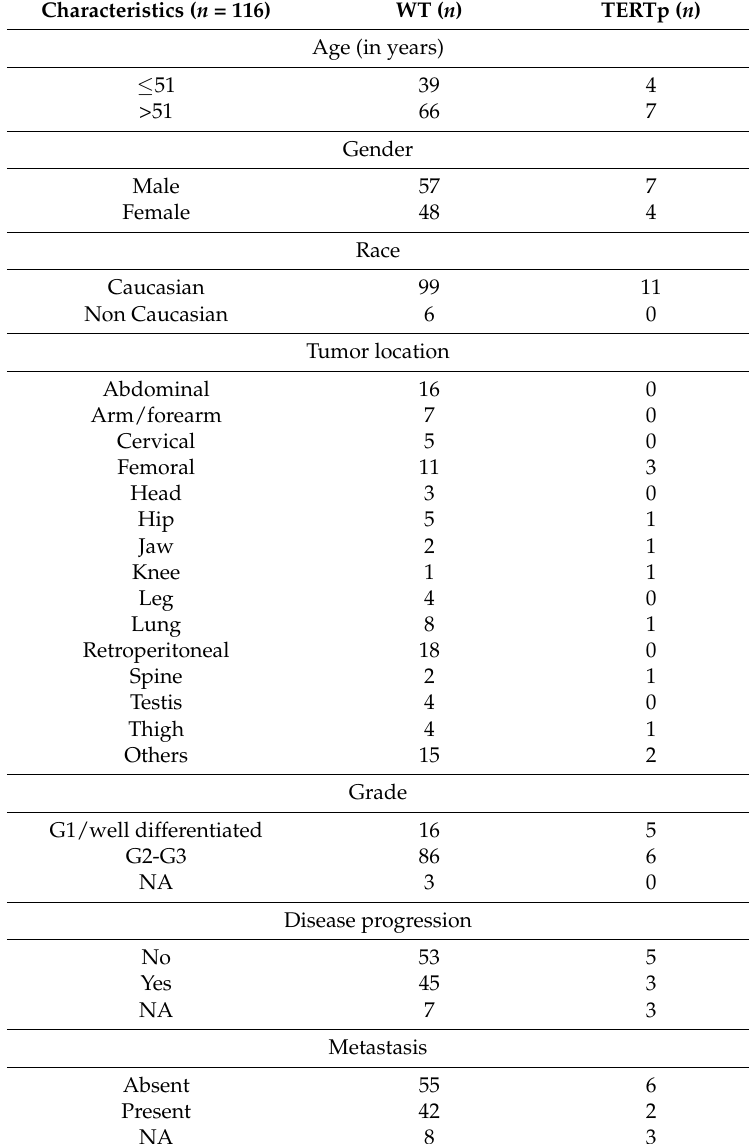
Table 2. Clinical characteristics of the selected cohort of soft tissue and bone sarcoma